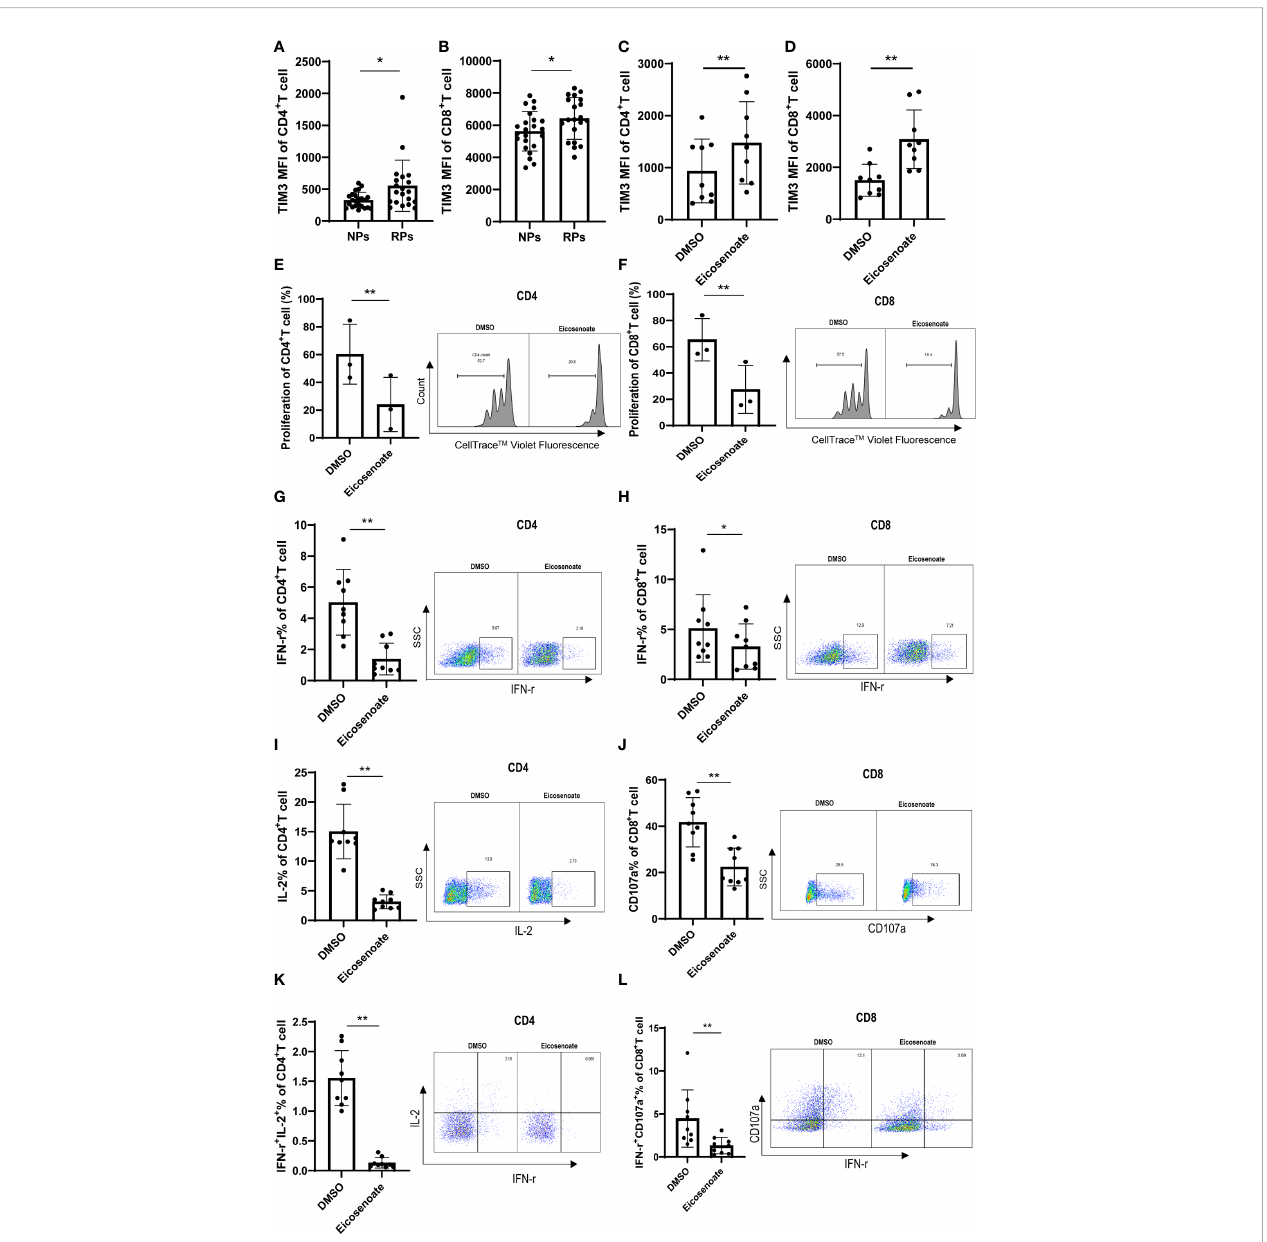
FIGURE 2 The lipid metabolite eicosenoate impairs T-cell function. To investigate the responses of cells to lipid metabolites, CD3 + T cells were stimulated with anti- CD3/CD28-coated Dynabeads (4:1 ratio) and 500 m M of the lipid metabolite eicosenoate simultaneously. (A, B) Exhaustion indicator TIM3 mean fl uorescence intensity (MFI) on CD4 + ( P < 0.05) and CD8 + ( P < 0.05) T cells in rapid progressors (RPs; n = 20) was higher than that in normal progressors (NPs; n = 23). (C, D) CD3 + T cells were co-incubated with DMSO or eicosenoate plus anti-CD3/CD28-coated Dynabeads (4:1 ratio) for 24 h and the expression of TIM3 was detected (n = 9). The expression of TIM3 on the surface of CD4 + ( P < 0.01) and CD8 + ( P < 0.01) T cells was signi fi cantly increased after a 24 h incubation with 500 m M eicosenoate. (E, F) Primary CD3 + T cells were labeled with Cell Trace ™ Violet and stimuli were added (anti-CD3/CD28-coated Dynabeads and 500 m M eicosenoate). After incubation for 5 d, dividing CD4 + and CD8 + T cells were analyzed. Eicosenoate signi fi cantly inhibited anti-CD3/ CD28-coated Dynabeads-induced proliferation of CD4 + ( P < 0.01) and CD8 + T cells ( P < 0.01) at 500 m M (n = 3). (G-L) Primary CD3 + T cells were stimulated with anti-CD3/CD28-coated Dynabeads (4:1 ratio) and 500 µM eicosenoate for 24 h, and GolgiStop (1 m l/mL) was added to the culture for the fi nal 6 h. IFN- g expression in anti-CD3/CD28-coated Dynabeads-stimulated CD4 + T cells (G, n = 9) ( P < 0.01) and CD8 + T cells (H, n = 9) was signi fi cantly reduced ( P < 0.05) in the presence of 500µM eicosenoate. IL-2 expression in anti-CD3/CD28-coated Dynabeads-stimulated CD4 + T cells (I, n = 9) was signi fi cantly reduced in the presence of 500µM eicosenoate ( P < 0.01). CD107a expression in anti-CD3/CD28-coated Dynabeads-stimulated CD8 + T cells (J, n = 9) was signi fi cantly reduced in the presence of 500µM eicosenoate ( P < 0.01). IFN- g and IL-2 co-expression in anti-CD3/CD28-coated Dynabeads-stimulated CD4 + T cells (K, n = 9) was signi fi cantly reduced in the presence of 500µM eicosenoate ( P < 0.01). IFN- g and CD107a co-expression in anti-CD3/CD28-coated Dynabeads-stimulated CD8 + T cells (L, n = 9) was signi fi cantly reduced in the presence of 500µM eicosenoate ( P < 0.01). In each panel, representative fl ow cytograms and comparisons of the parameters between eicosenoate-stimulated T cells and controls are shown. * P < 0.05 and ** P < 0.01. P values were calculated by Mann-Whitney test (A, B) , Wilcoxon matched-pairs signed rank test (C, D, G-L) , Paired t test (E, F)